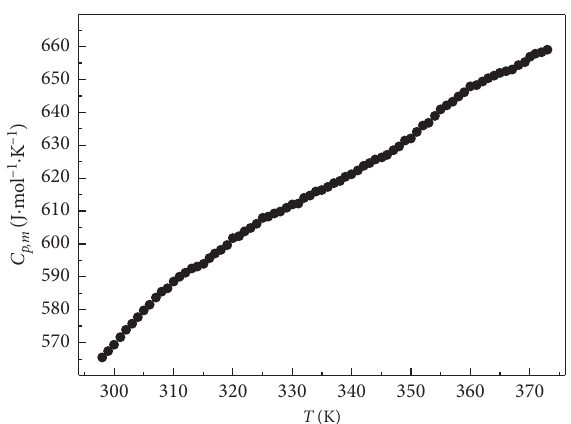
Figure 3: Experimental molar heat capacity of β -CsB